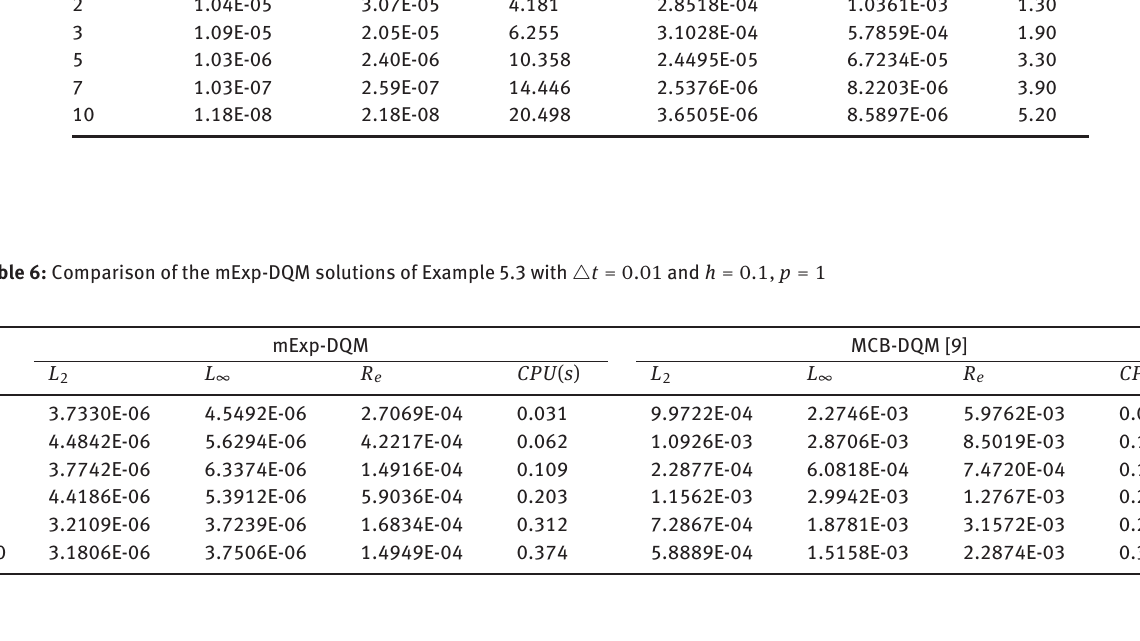
Table 7: Comparison of the mExp-DQM solutions of Example 5.3 with (cid:2) t = 0.001 ; h = 0.05 and p = 1, 0.15